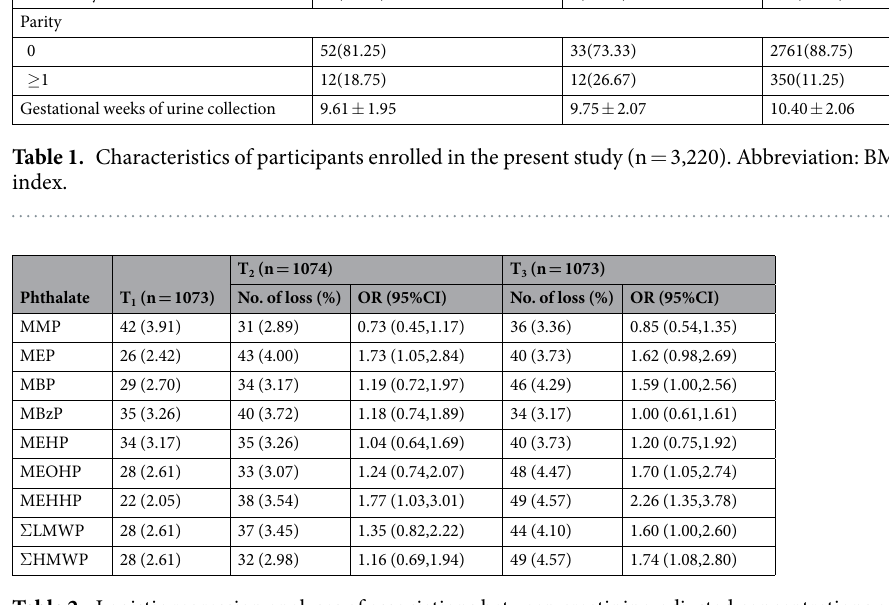
Table 2. Logistic regression analyses of associations between creatinine-adjusted concentrations of phthalate metabolites and clinical pregnancy loss. Abbreviations: OR, odds ratio; CI, confidence interval; T 1/2/3 , the